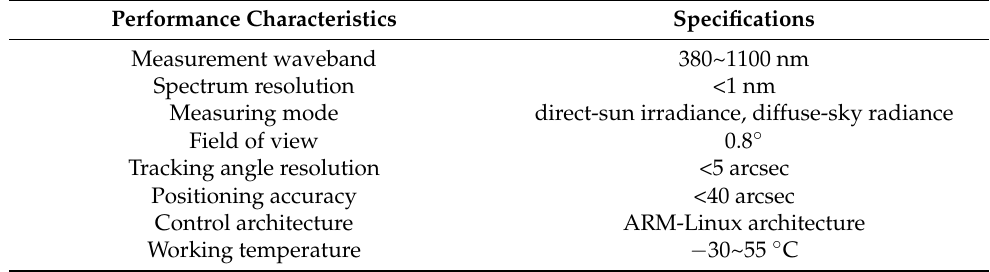
Figure 1. Schematic diagram of instrument. Table 1. Main features of spectroradiometer.